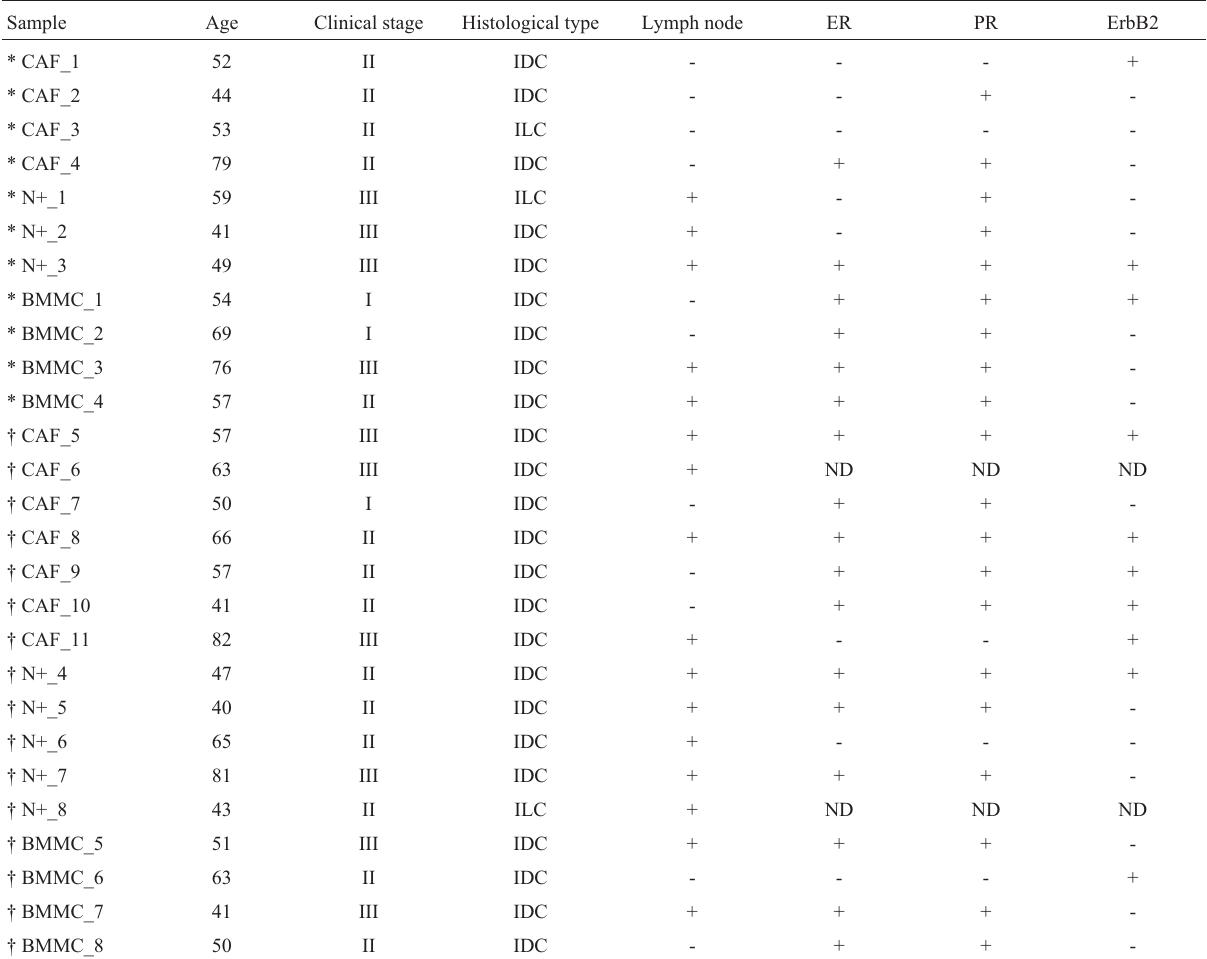
Table 1 - Patients characteristics.